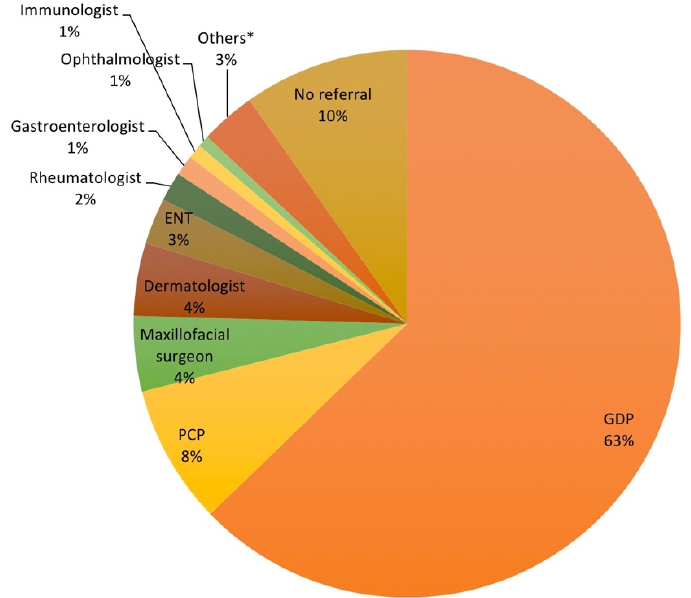
Figure 1. Source of referral. * Others: Oncologist, Pathologist, Plastic surgeon, Neuropsychiatric, Pediatrician, Breast specialist, Allergist, Cardiologist, Hematologist, Gynecologist, Internist, Neurologist. ENT: ear-nose-throat specialist; PCP: primary care physician; GDP: general dental practitioner.